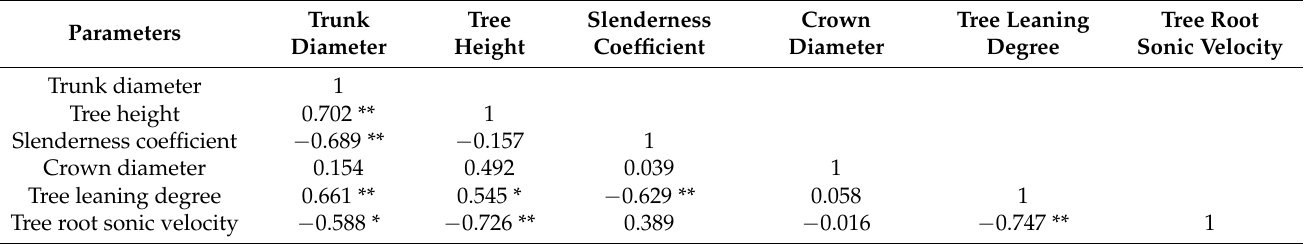
Figure 5. Boxplot of the distribution of tree diameter (dbh) ( a ) and tree height ( b ) of Samanea saman and Delonix regia . Table 1. Pearson’s correlation for analysis of tree morphometric parameter and tree root sonic velocity (n =